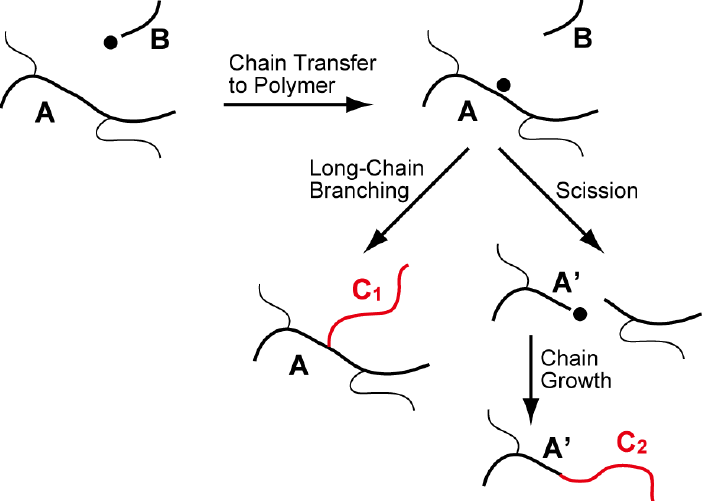
Figure 1. Schematic representation of the process of chain transfer to polymer, leading to long-chain branching and